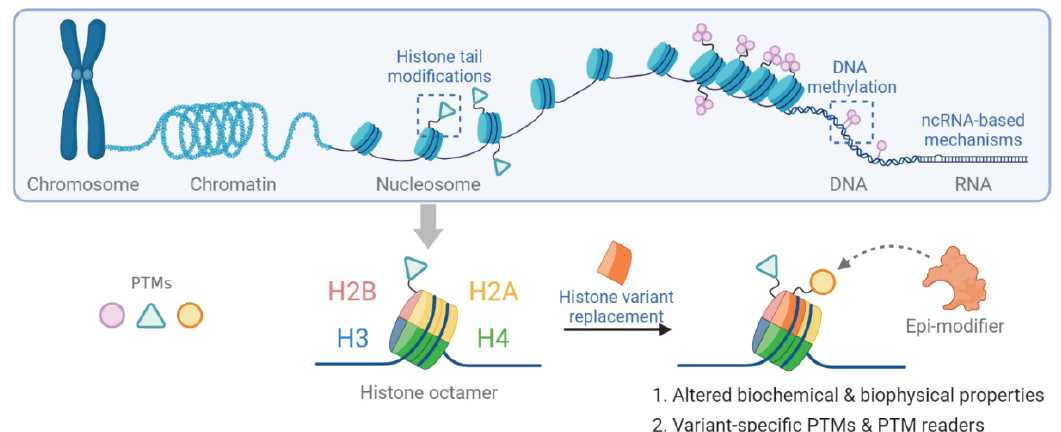
Figure 1. Schematic representation of epigenetic mechanisms including histone tail modification, histone variant replace- ment, DNA methylation and non-coding RNA-based mechanisms.